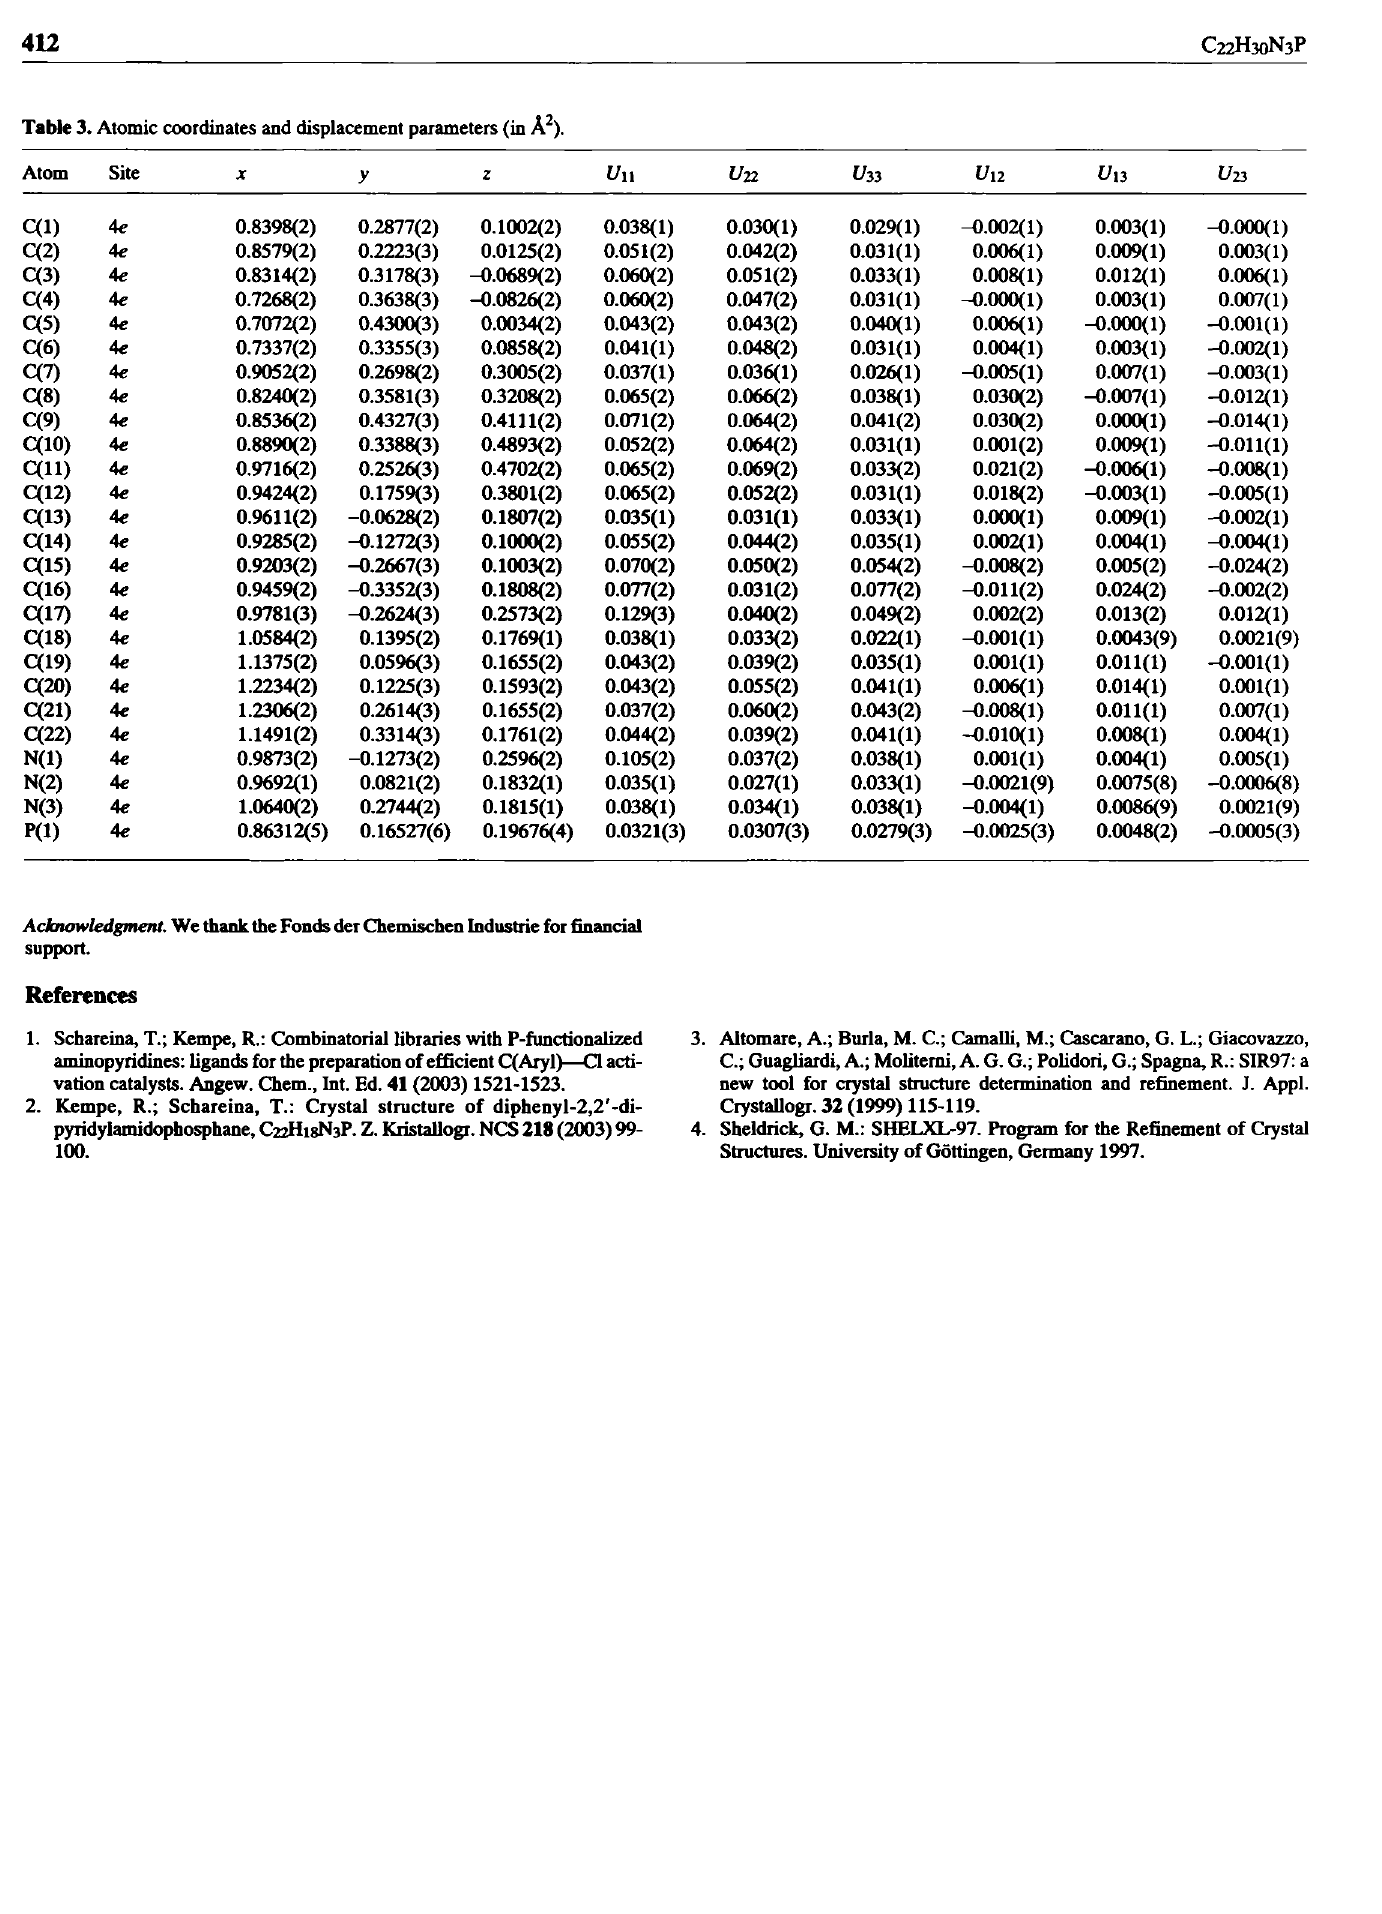
Table 3. Atomic coordinates and displacement parameters (in A 2